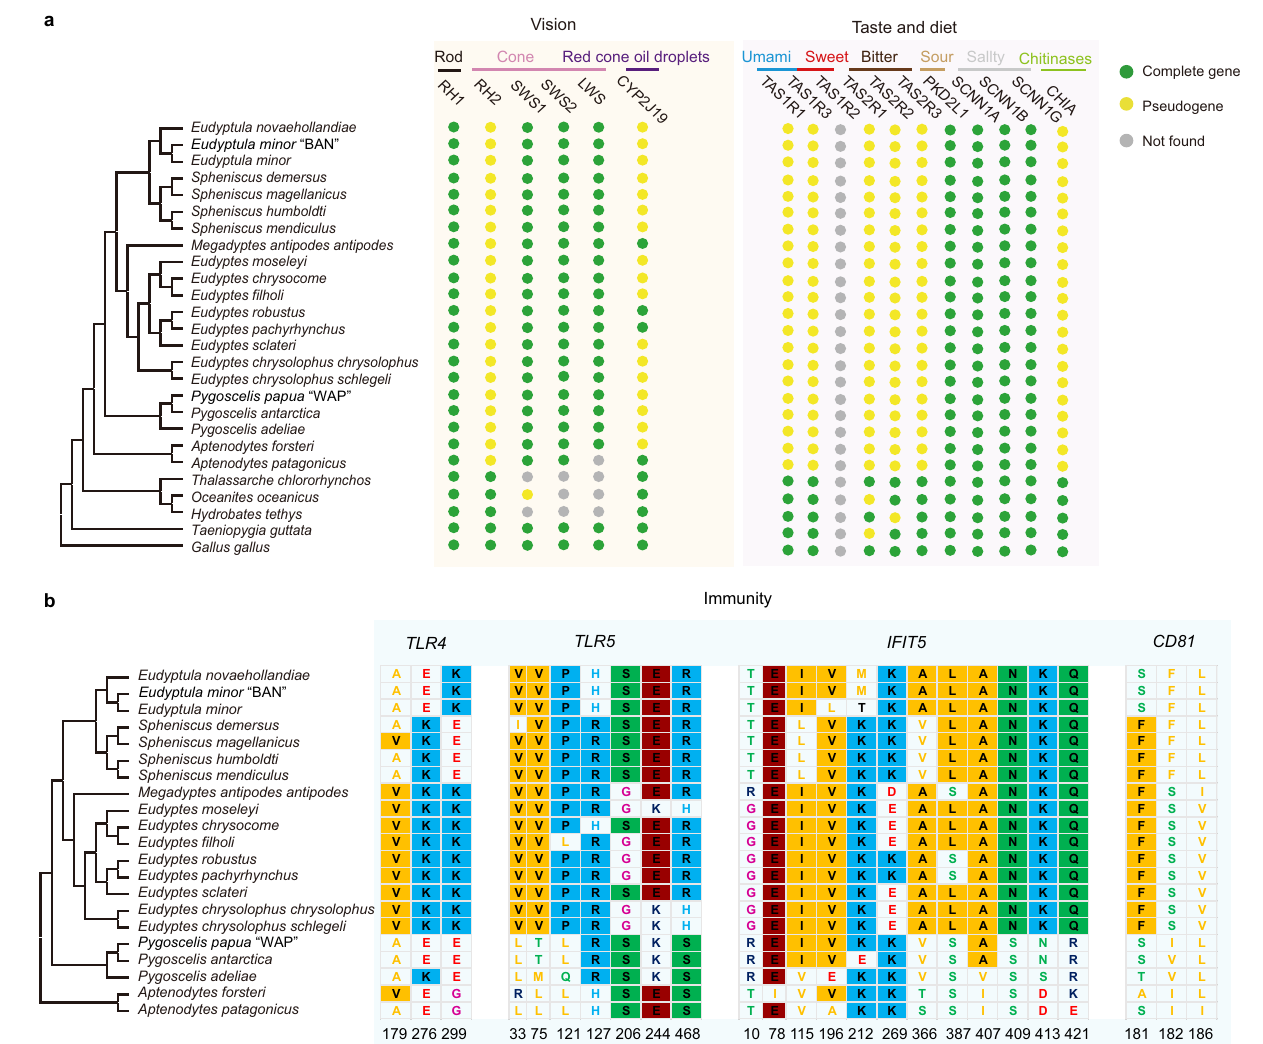
Fig. 5 Pseudogenes and site alignments for vision, taste, diet, and immunity genes. a Presence/absence of vision, taste, and dietary genes in penguins. Phylogenetic tree of penguins and select outgroups indicate which species have complete or pseudogenes, related to vision (opsins; RH1 , RH2 , SWS1 , SWS2 , LWS, and CYP2J19 ), taste (umami; TAS1R1 , TAS1R3 , sweet; TAS1R2 , bitter; TAS2R1 , TAS2R2 , TAS2R3 , sour; PKD211 , salty; SCNN1A , SCNN1B , SCNN1G ) and diet (chitinase; CHIA ). “ Not found ” indicates genes that could not be assembled. b Phylogenetic tree of penguins showing alignments of positively selected sites for four genes related to immunity ( TLR4 , TLR5 , IFIT5, and CD81 ). Sites are shown below the alignment. The background colors are displayed for sites that have 50% conservation. Source data is provided as a Source Data fi